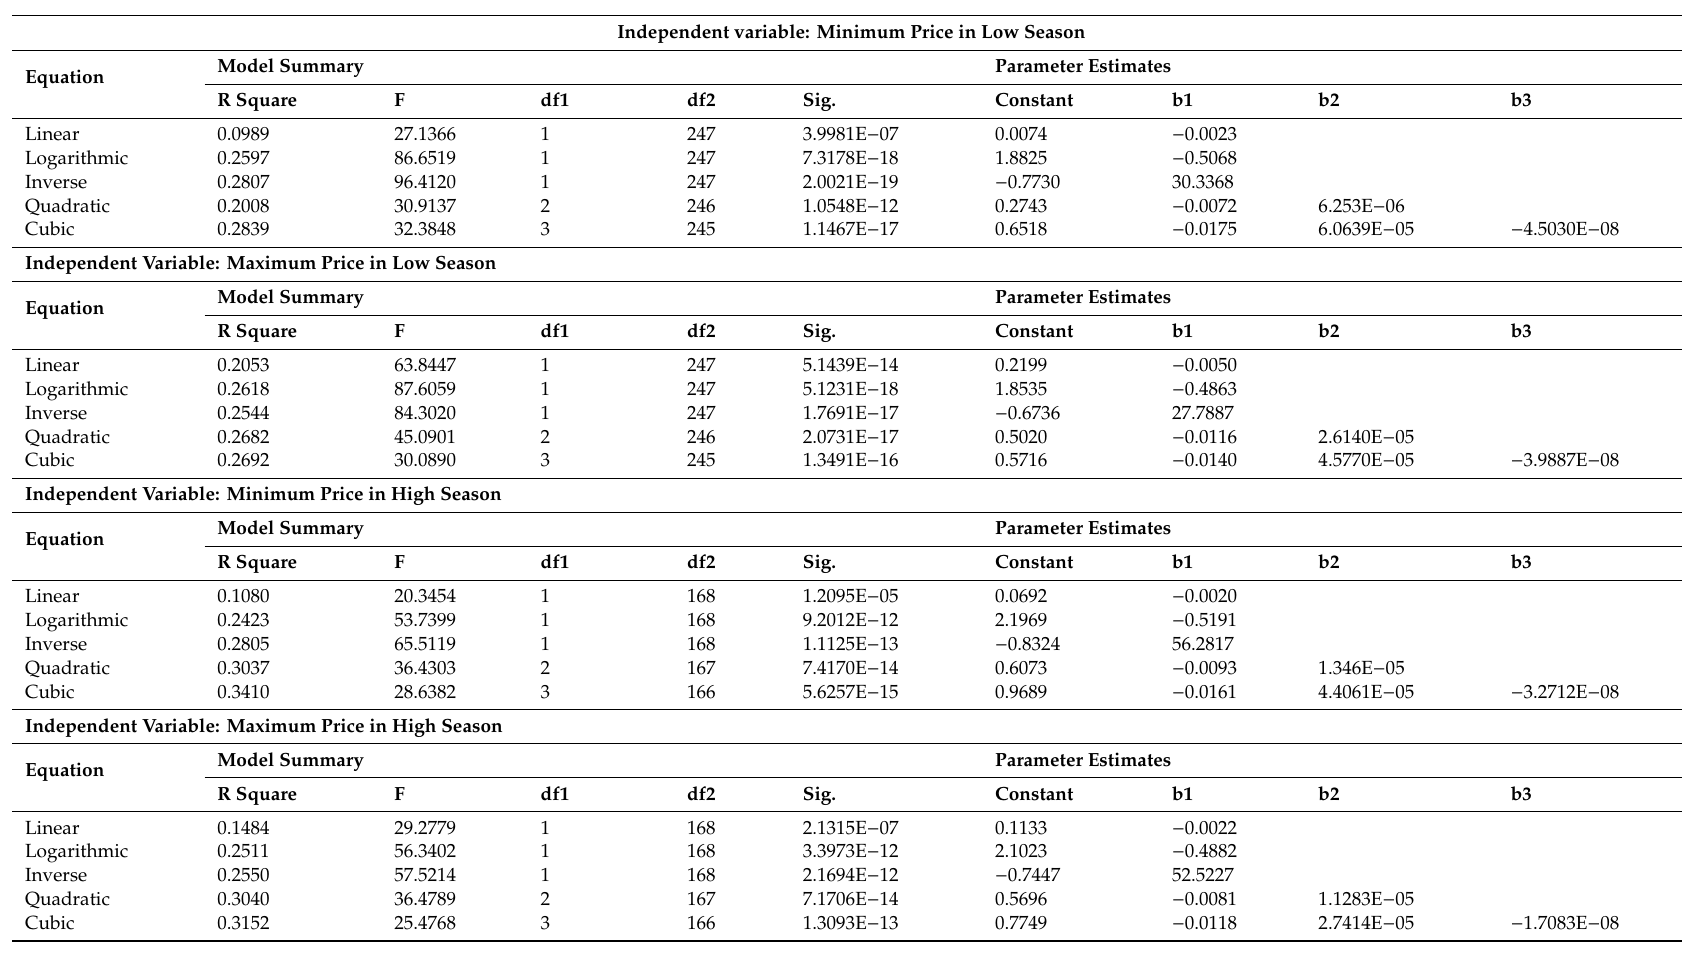
Table 7. Model summary and parameter estimates of regression analysis in Gran Canaria destination with added value as dependent